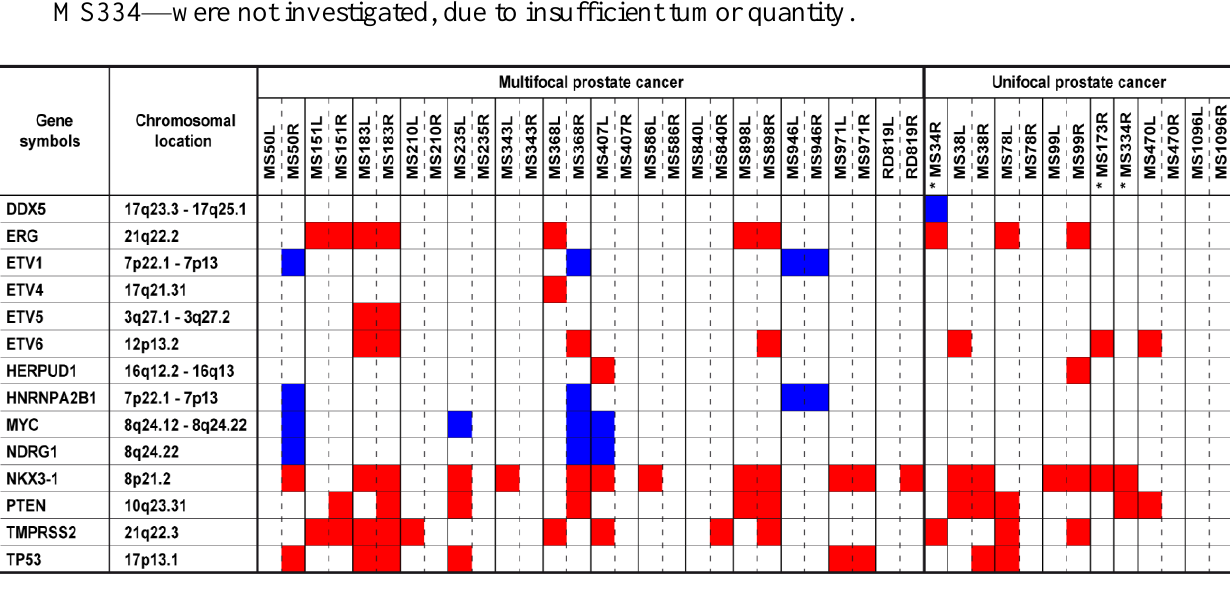
losses and blue represents gains. Gene list obtained from http://www.sanger.ac.uk/genetics/ CGP/Census/ [22]. (*) Matching left samples from these cases—MS34, MS173 and MS334—were not investigated, due to insufficient tumor